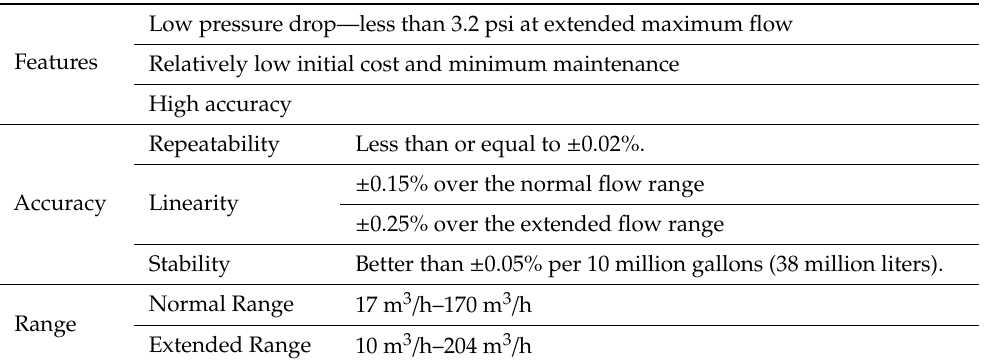
Table 1. Device characteristics.